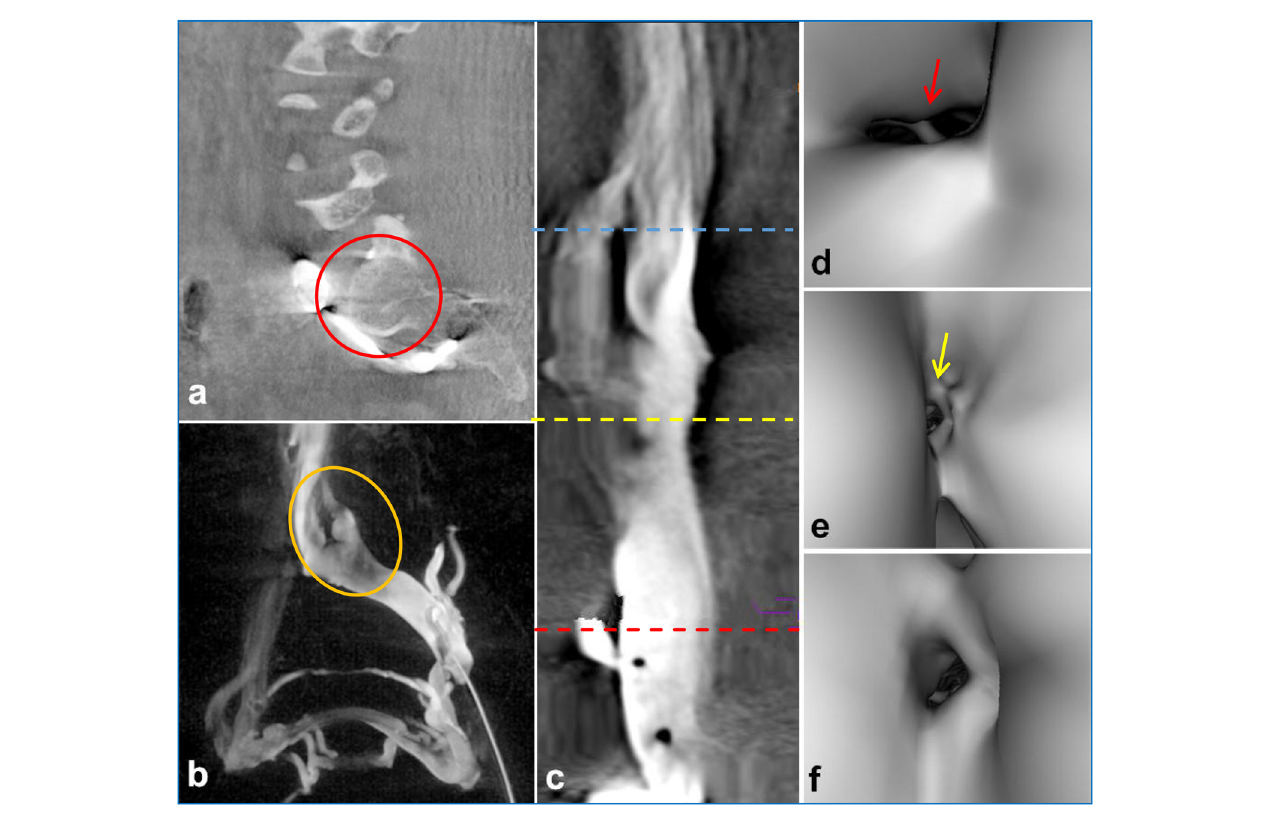
FIGURE2 3D-RV image depicted compression of the iliac vein by the posterior lumbar spine [ (a) , red circle]. The coronal view showed an indentation of the left common iliac vein [ (b) , yellow circle]. Intravascular virtual endoscopic imaging displayed the entrance of the inferior vena cava [ (c) blue line, (d) arrows], stenosis [ (c) yellow line, (e) arrows] and normal intraluminal morphology [ (c) red line, (f) arrows], and the “ridge” morphology at the compression site of the left common iliac vein [ (d) ,